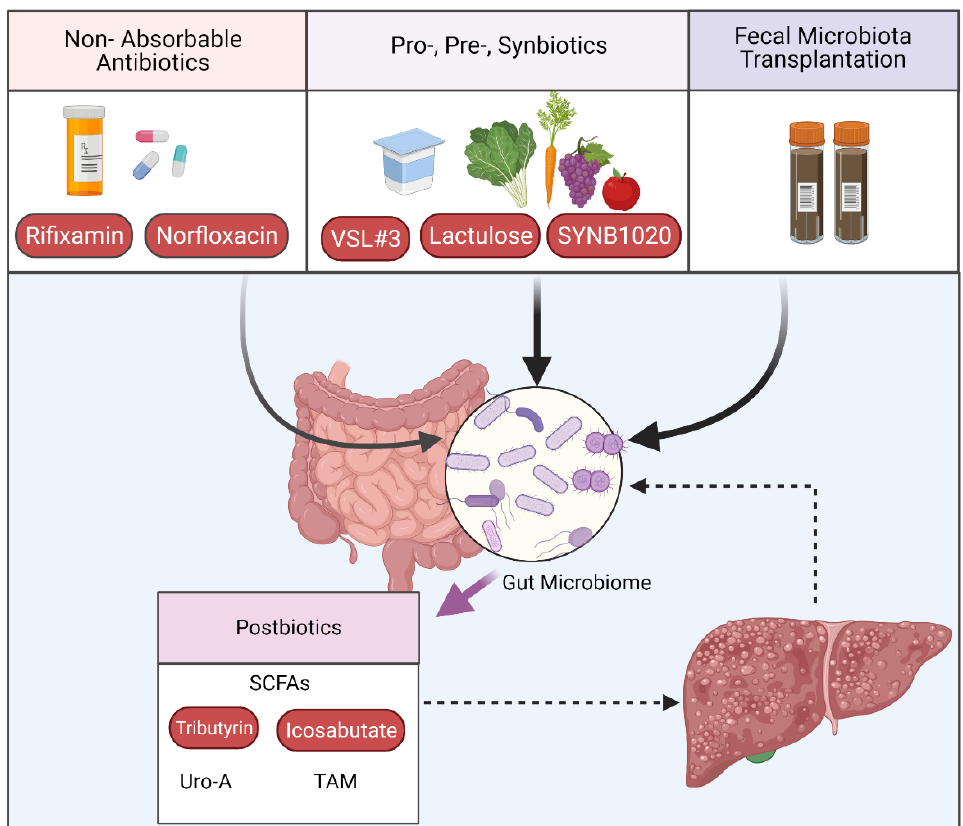
Figure 3. Interventions targeting the intestinal microbiome. Advances in our knowledge of the gut–liver axis are driving the development of therapeutic tools based on microbiota composition and its metabolites (postbiotics). Modifying intestinal content with non-absorbable antibiotics (Rifixamin, Norfloxacin) or specific pro- pre- or synbiotics (VSL#1, lactulose, SYNB1020) or target fecal microbiota transplantation are increasingly recognized in clinical trials as effective interventions targeting the microbiome to effectively treat liver disease. SCFAs, short-chain fatty acids; TAM, trimethylamine; Uro-A, Urilothlin-A.